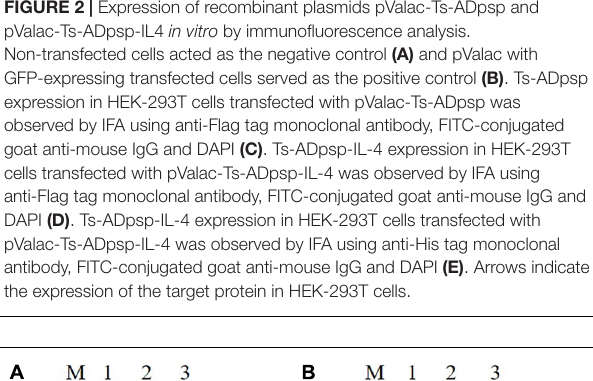
FIGURE 4 | Invasion rates of invasive and non-invasive recombinant L. plantarum in BHK-21 cells. Recombinant L. plantarum was cocultured with BHK-21 cells and cultured in solid MRS (Em, Cm) at 37 ◦ C for 24 h; the number of intracellular bacteria was counted to calculate cell invasion rates. All experiments were independently repeated at least 3 times. Data are shown as means ± standard deviations; n = 3. ** P <